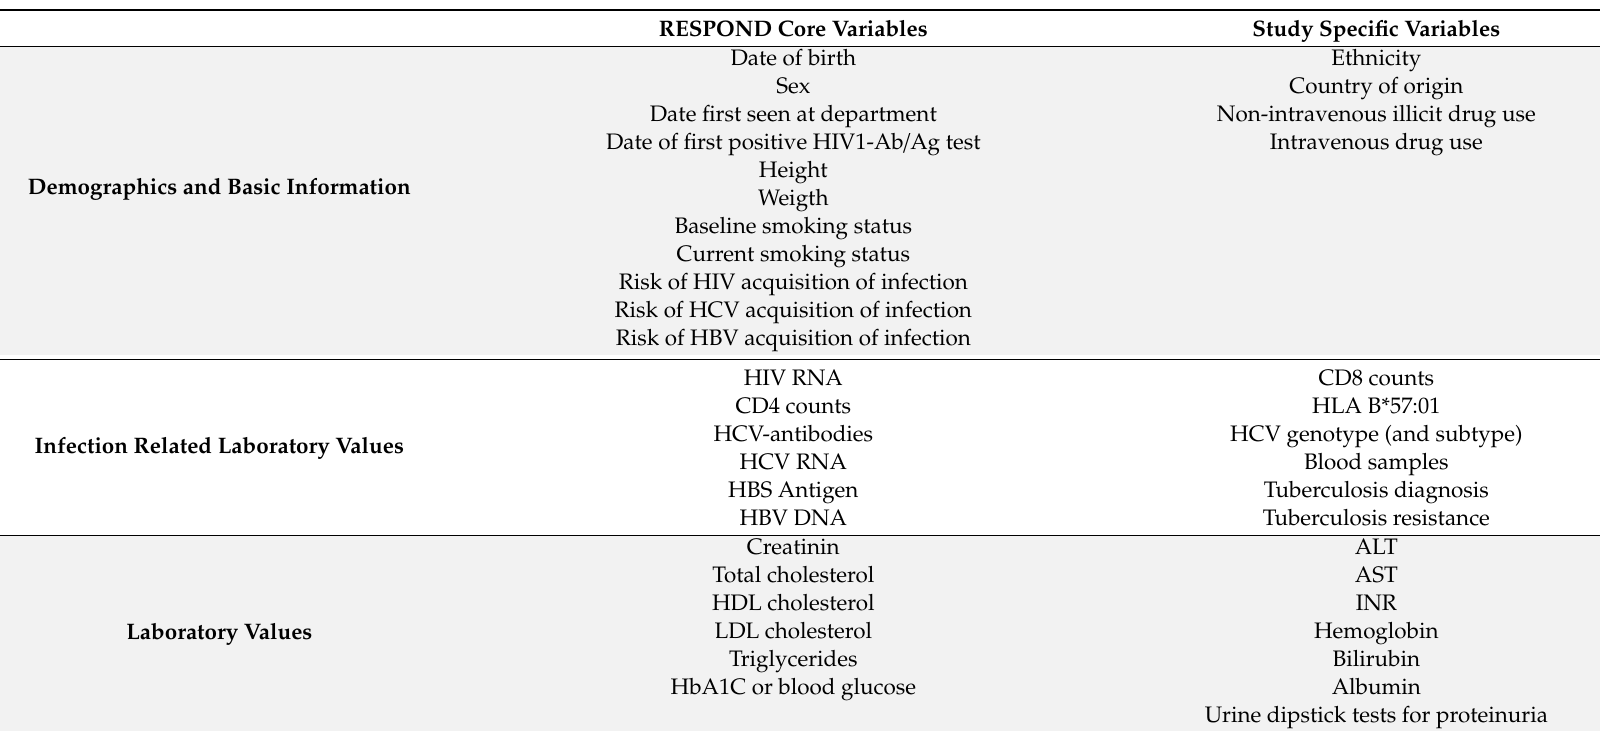
Table 1. Overview of the RESPOND core variables collected by all the participating cohorts, and study-specific variables collected as part of the RESPOND